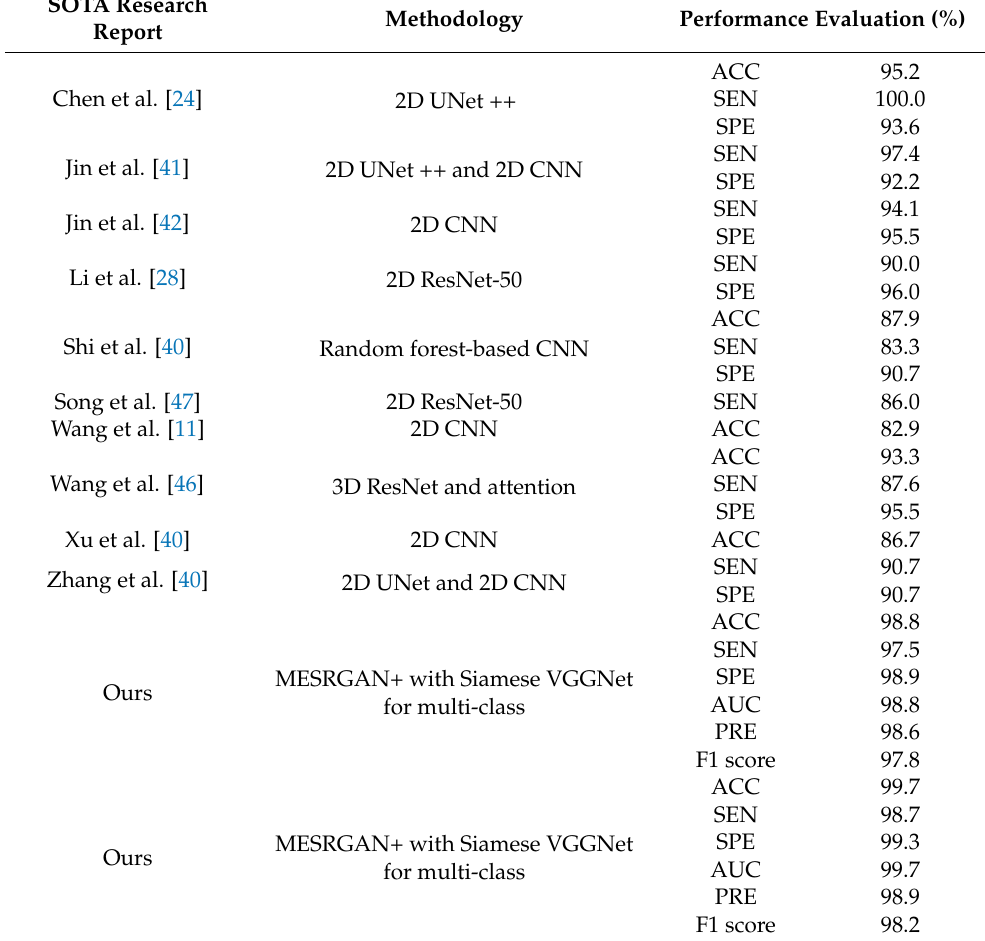
Table 5. Comparison of our proposed model with other state-of-the-art COVID-19 screening methods.